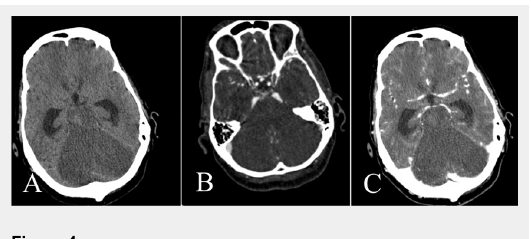
Non-contrast CT (A) and venous-phase CT (B): Opacification of the superficial temporal artery indicates sufficient contrast injection (Arrowheads). Note also opacification of an M4 segment artery on the right, a marker of some residual cortical perfusion. In this case, circulatory arrest could not be